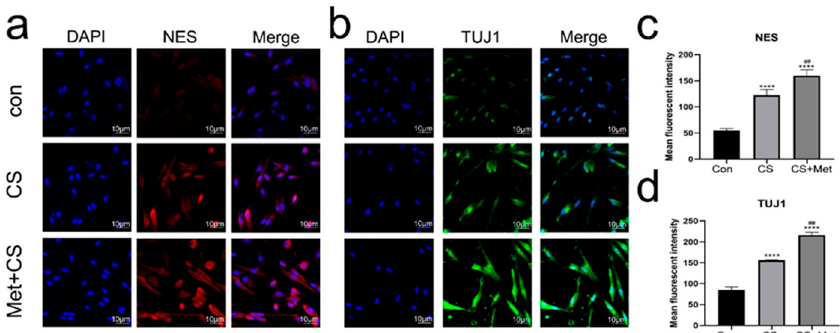
Figure 4. Characterization of immunofluorescence image of neural differentiation of GMSCs. ( a ) Immunofluorescence image of NES protein in Con group, CS Group, and Met–CS group. The red fluorescence represents NES. ( b ) Immunofluorescence image of TUJ1 protein in Con group, CS Group, and Met–CS group. The green fluorescence represents TUJ1. ( c ) Statistical graph of average fluorescence intensity of NES protein. ( d ) Statistical graph of average fluorescence intensity of TUJ1 protein. Con, control group; CS, chitosan hydrogel cultured group; Met–CS, cells under chitosan hydrogel culture with entrapment metformin and growth factor. Data are expressed as the mean ± SEM; n = 3, p < 0.0001 ****.